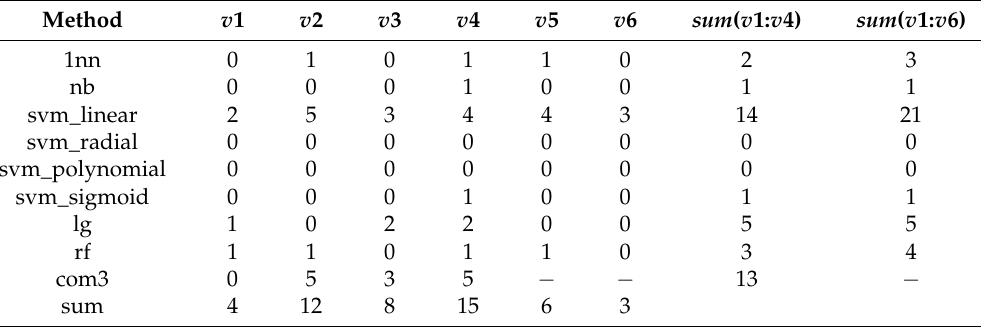
Table 13. Best results for THRESHOLD 0.65 : We counted the number of times the sensitivity threshold of 0.65 was exceeded. We considered variants v1 to v6. The best method was found to be svm_linear and com3 and variants v4 and v2. Slightly better were v4 and svm_linear. It is worth noting that com3 also includes svm_linear. In yellow, we highlighted the best methods and variants. Method v 1 v 2